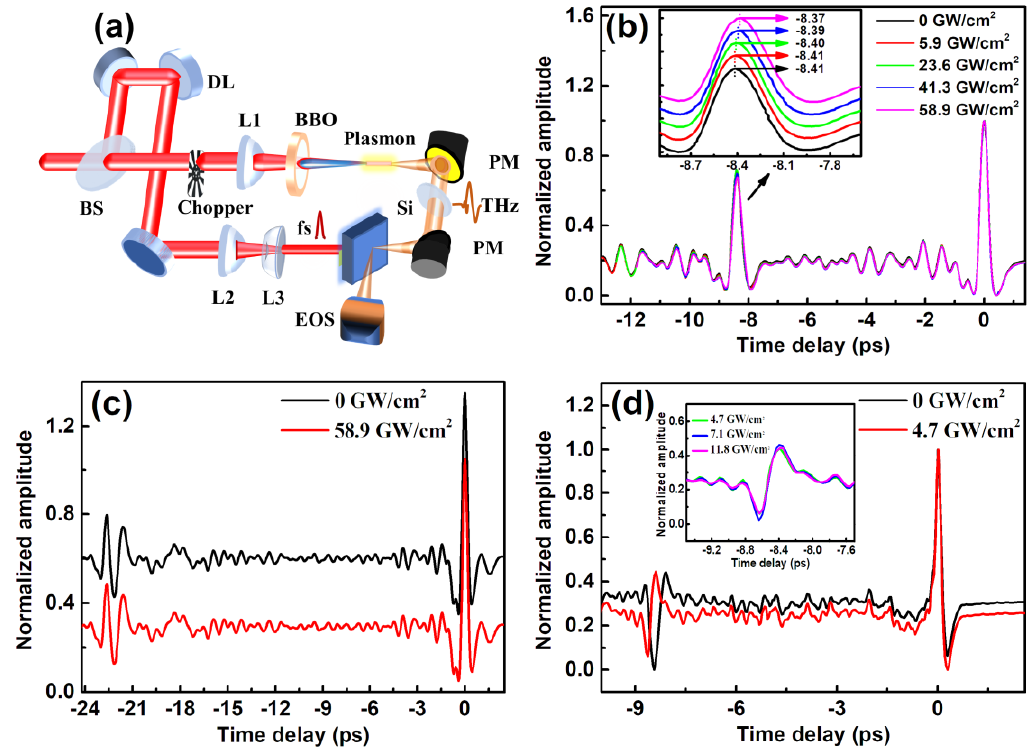
Figure 3. ( a ) Schematic of laser-pumped and THz-probed setup: BS, beam splitter; DL, optical delay line; L1 and L2, convex lens; L3, concave lens; BBO, β -barium borate crystal; PM, parabolic mirror; EOS, electro-optic sampling. The waveforms of THz probe pulses reflected from different samples of ( b ) NPG/GaAs, ( c ) NPG/SiO 2 and ( d ) intrinsic GaAs were measured under different pump intensities; ( b ) The left peak of the reflected THz pulse is zoomed in the inset. Each curve was normalized and added a value of 0.2 respectively in order to distinguish imperceptible shift; ( c ) The curves were normalized. The black curve was added a value of 0.4; ( d ) The curves were normalized. The inset is the left THz pulse measured under different pump intensities.